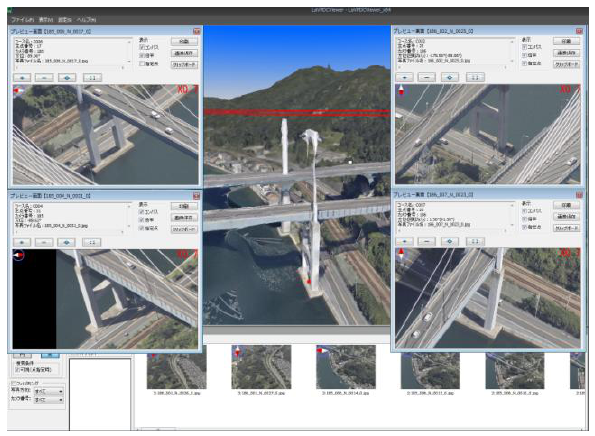
Figure 5. digital aerial photographs of a bridge column